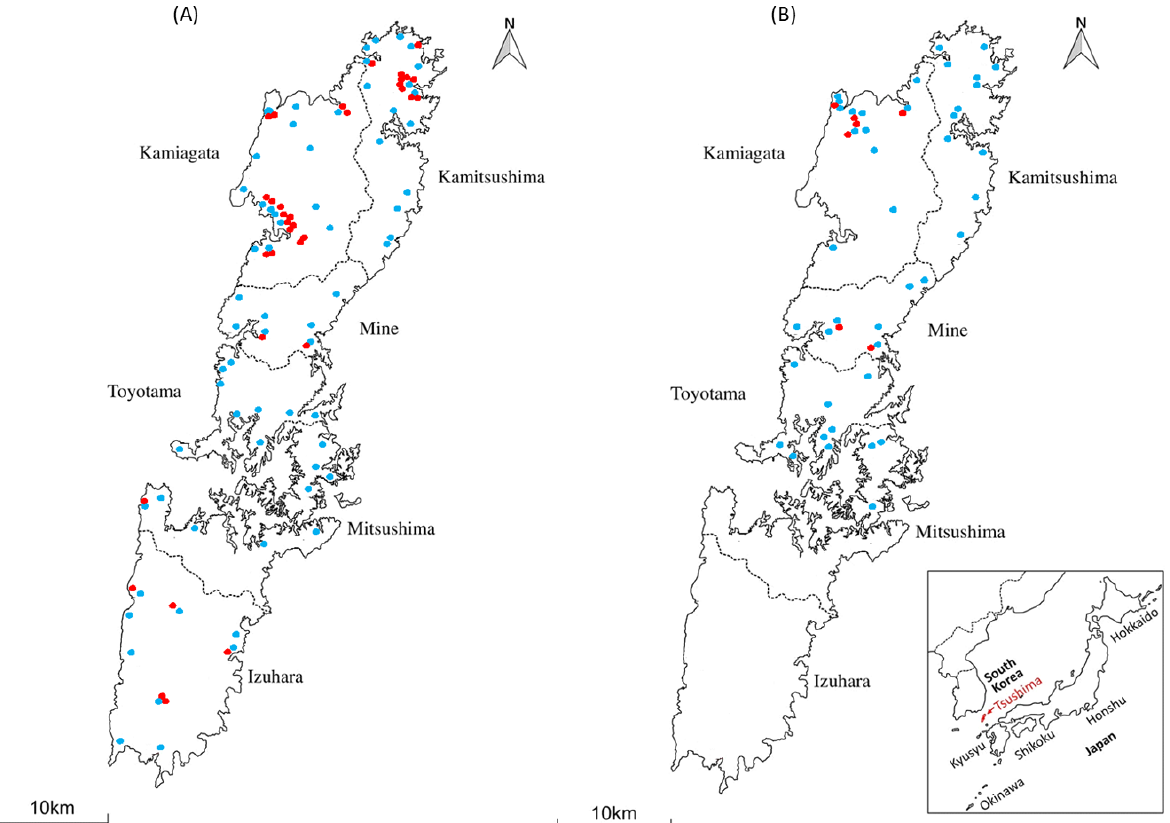
Figure 1. Maps of Tsushima Island and sample collection sites. ( A ) Map of sample collection sites for domestic cats. ( B ) Map of sample collection sites for wild cats. Blue dots indicate sample locations. Red dots represent positive samples.